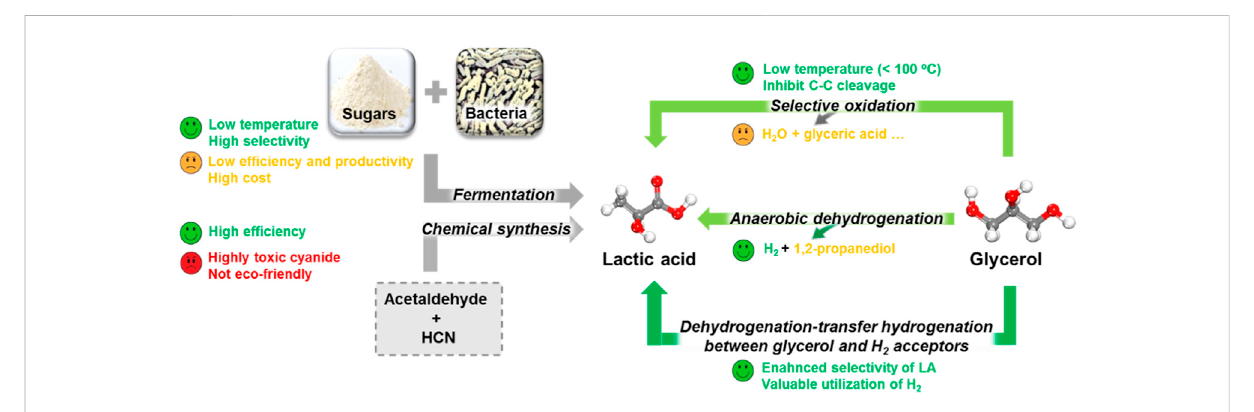
FIGURE 2 Diagram of nature circulation of poly-(LA).